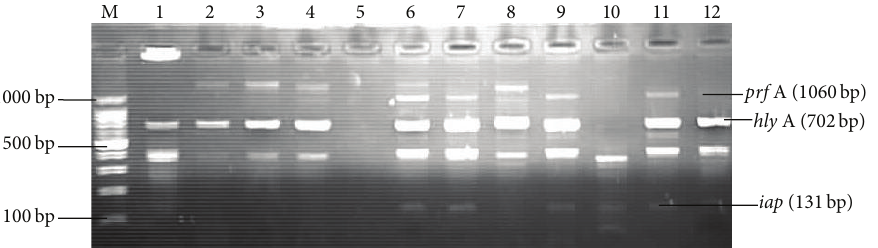
Figure 2: Agarose gel electrophoresis result for multiplex PCR following amplification of prf A, hly A, and iap virulence-associated genes. Lane M: molecular weight marker (Promega) in base pairs; Lane 1: Listeria monocytogenes (LM) ATTC 19155; Lane 2: LM isolate ZKMM84; Lane 3: LM SGHRR30; Lane 4: LM SGSK1; Lane 5: negative control; Lane 6: LM ZKJR55; Lane 7: LM SGHR39; Lane 8: LM ZKMR75,=; Lane 9: LM SGMM37; Lane 11: LM SGHR15; Lane 12: LMFR162.